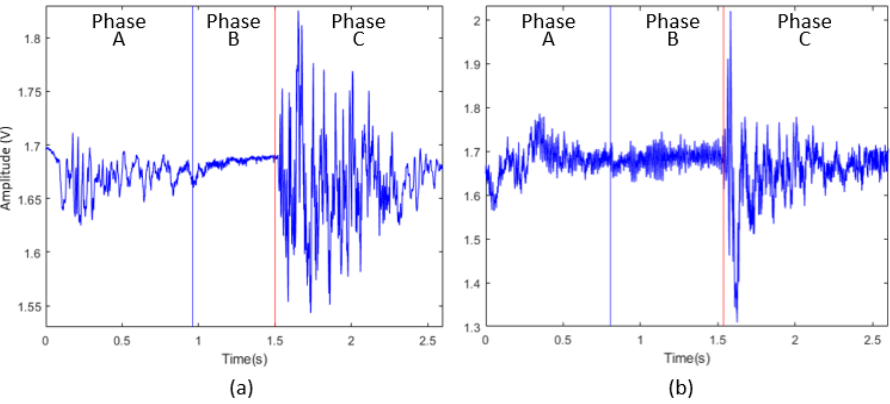
Figure 7. Classification of respiratory phases for one respiratory cycle: ( a ) waveform showing phase dividing line in flow rate data, ( b ) waveform showing phase dividing line in signal obtained by adding microphone and flow rate data.